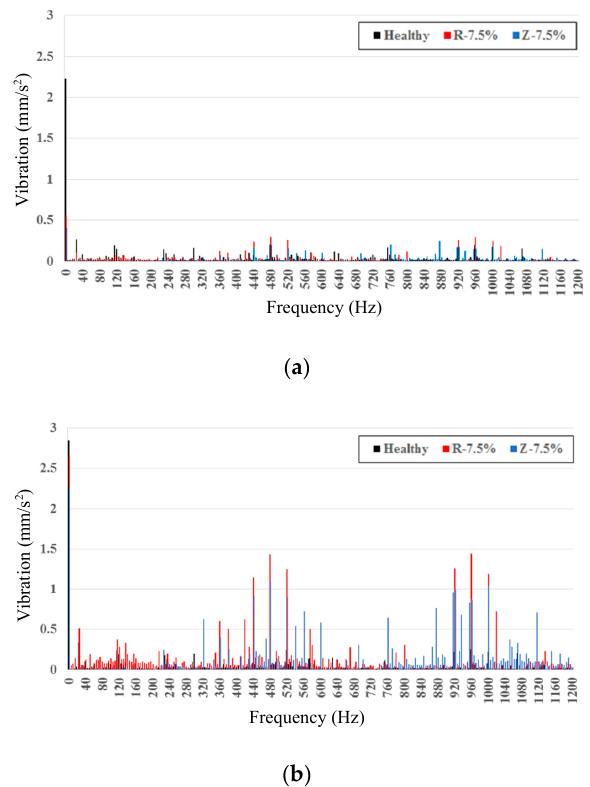
Figure 13. FFT analysis for calculated vibration waveforms: ( a ) no load; ( b ) 70% load. Table 3. Calculated amplitudes of